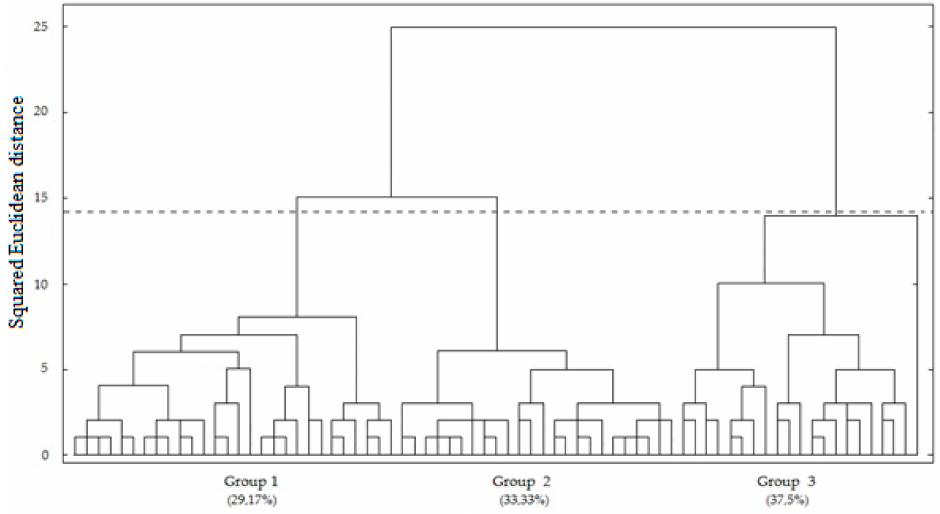
Figure 6. Dendrogram using Ward’s linkage: Communities in sector B (Samona Yuturi, Chiru Isla, Sinchi Chicta Cari, and San Vicente) in the north of the Yasun í Biosphere Reserve in the Ecuadorian Amazon region (percentage of chakras in each